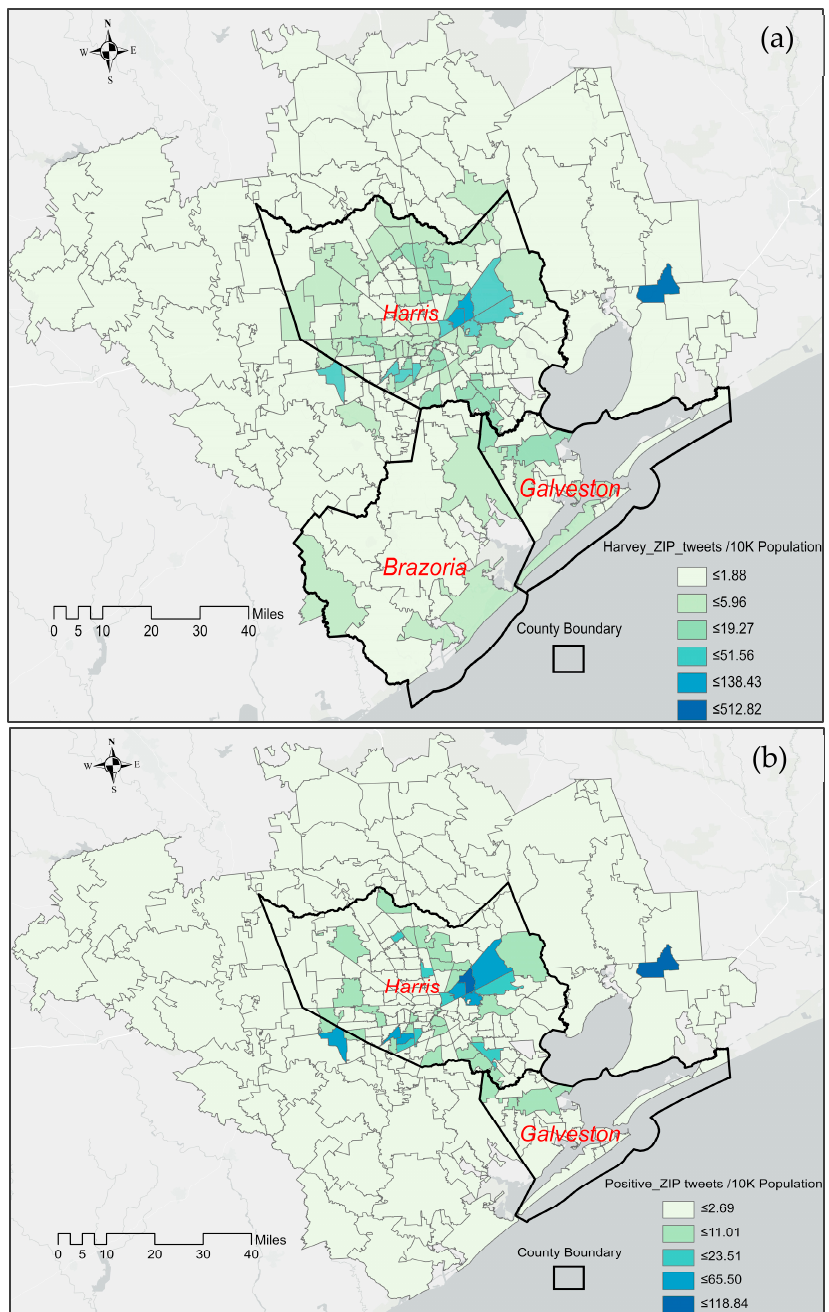
Figure 3. Choropleth maps showing the geospatial distribution of Harvey_ZIP_tweets ( a ) and positive_ZIP ( b ).